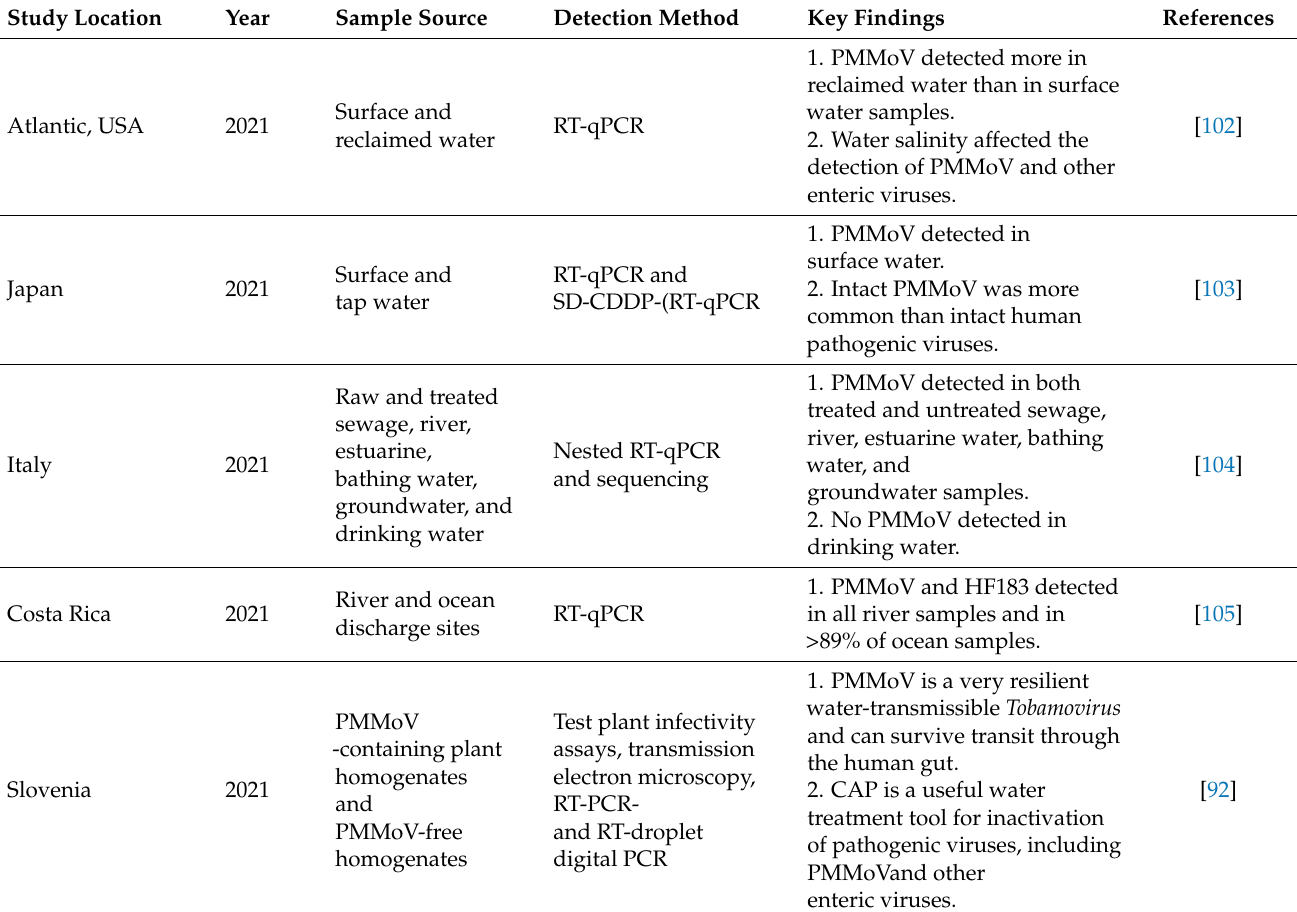
Table 5. Research findings on the detection of PMMoV in water resources and in animal (including human)